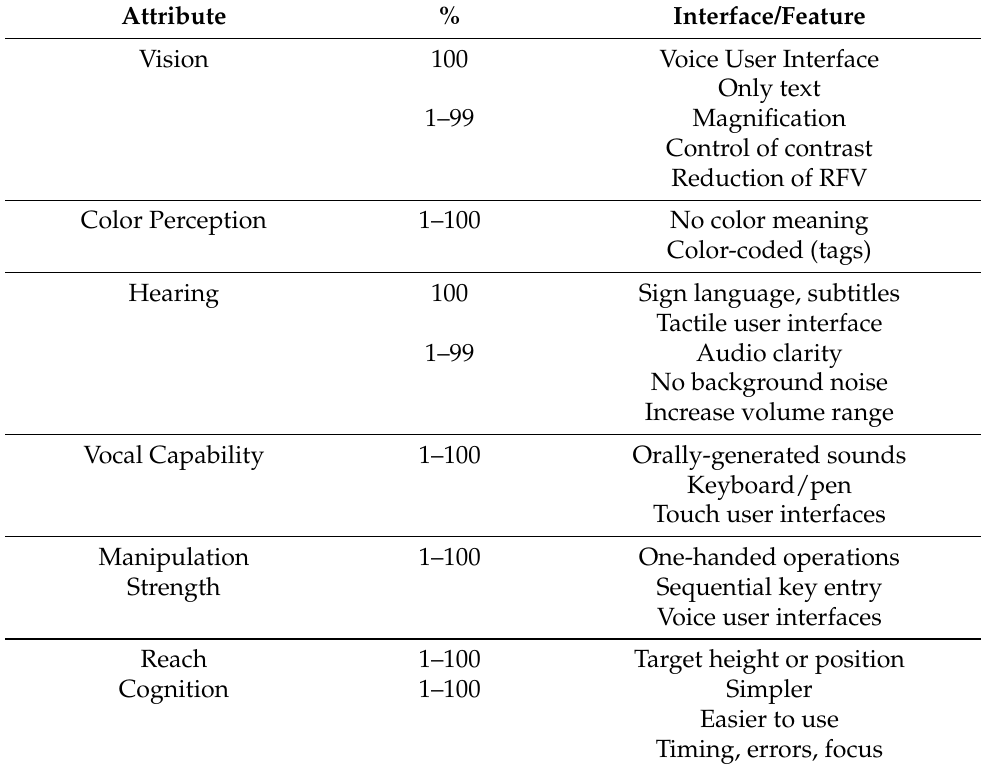
Table 2. Functional